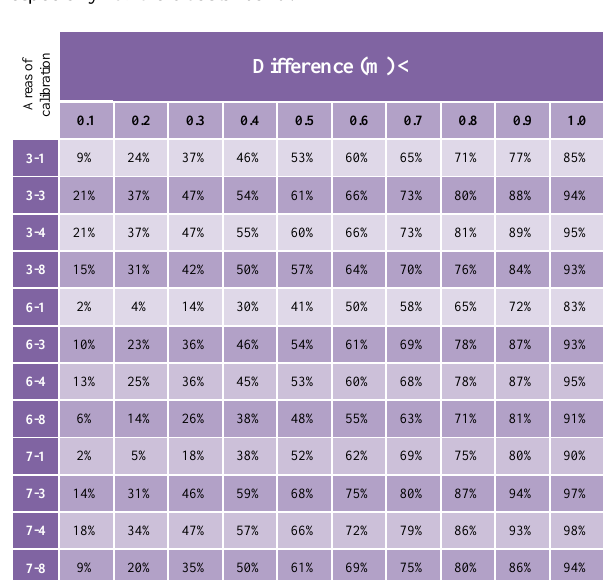
Table 7: Percentiles of the differences between the remaining calibration areas of image 5419 and those of image 5318 which are lower than the thresholds indicated by the column